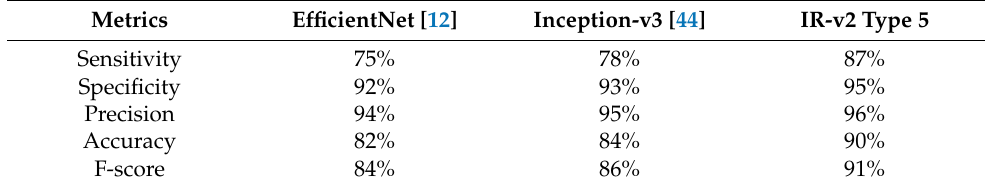
Table 6. Comparison of recent methods with our proposed method taken from a public dataset